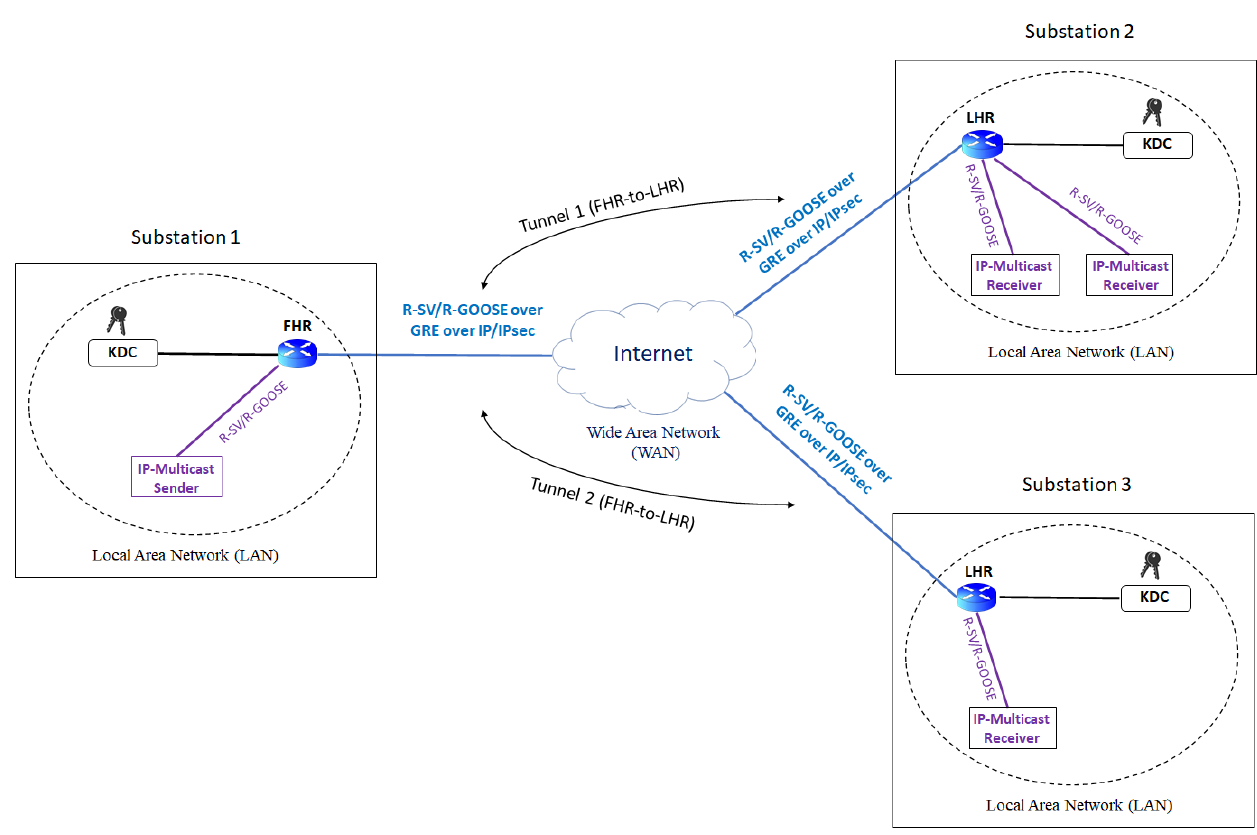
Figure 17. P2M architecture for multicast R-SV/R-GOOSE over public WAN (Internet) with separate GRE tunnels.